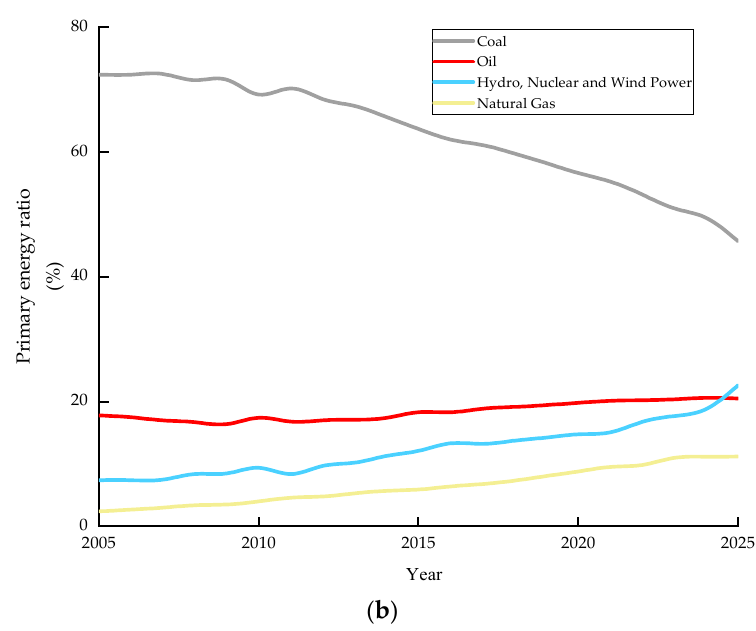
Figure 9. ( a ) Prediction results of primary energy demand forecast; ( b ) prediction results of primary energy ratio.